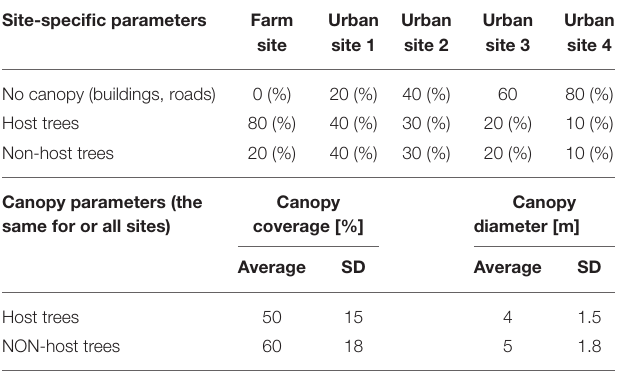
TABLE 2 | Landscape structure